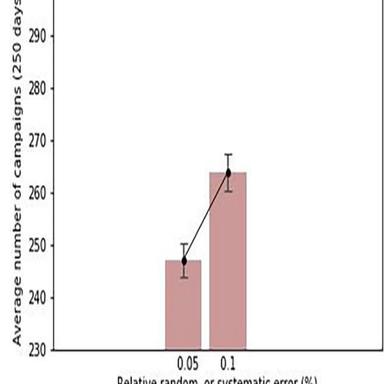
2. A higher number of campaigns went through during the second simulation with the relative random and systematic errors of 0.1% each. The average number of campaigns for the first simulation is 247 ± 3.2, and that for the second simulation is 264 ± 3.5.